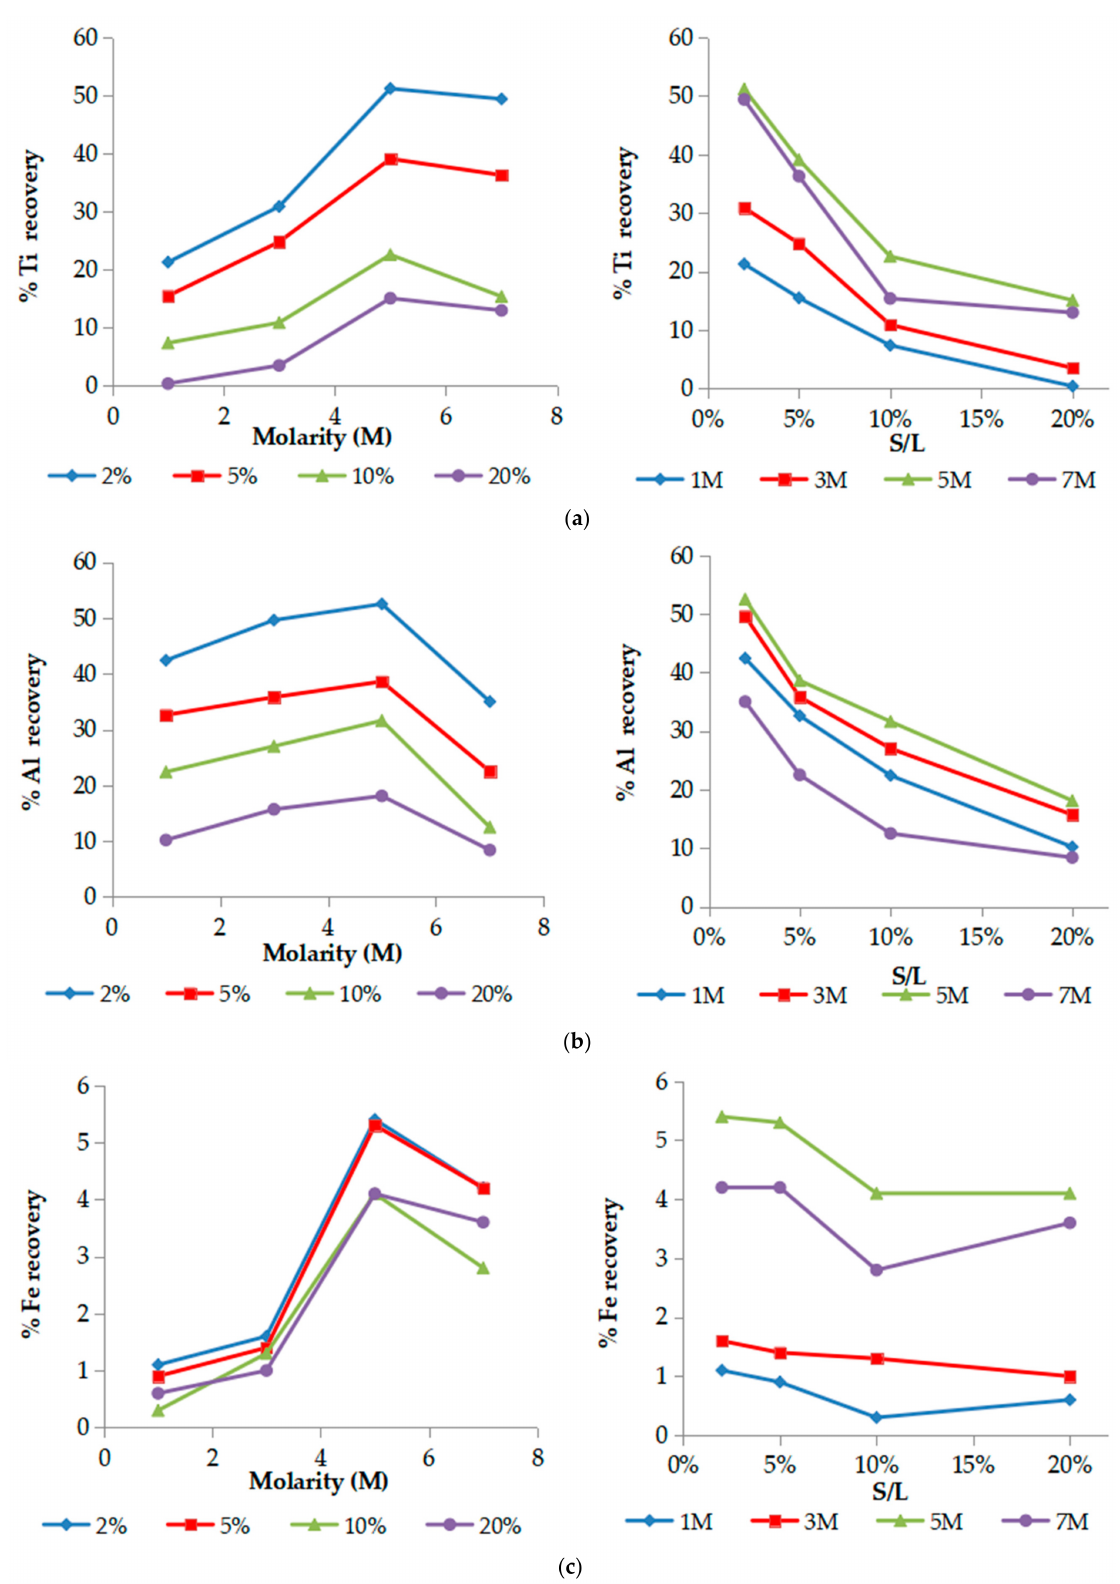
Figure 3. Effect of acid molarity ( left ) and S/L ratio (pulp density) ( right ) on % Ti recovery ( a ), % Al recovery ( b ), % Fe recovery ( c ). (T = 25 ◦ C, t = 60